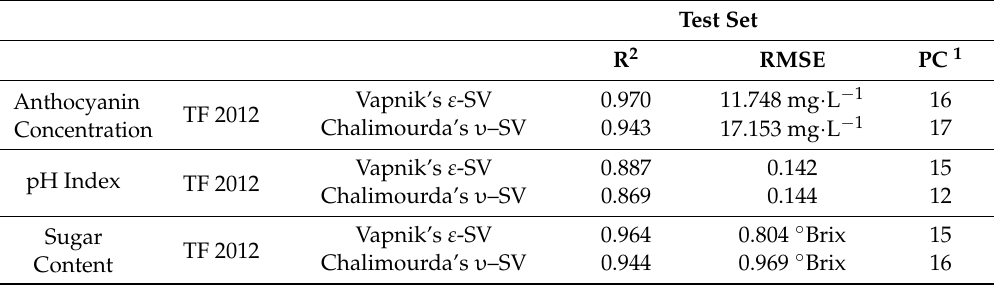
Table 2. Experimental results to build the support vector regression model with different loss functions.